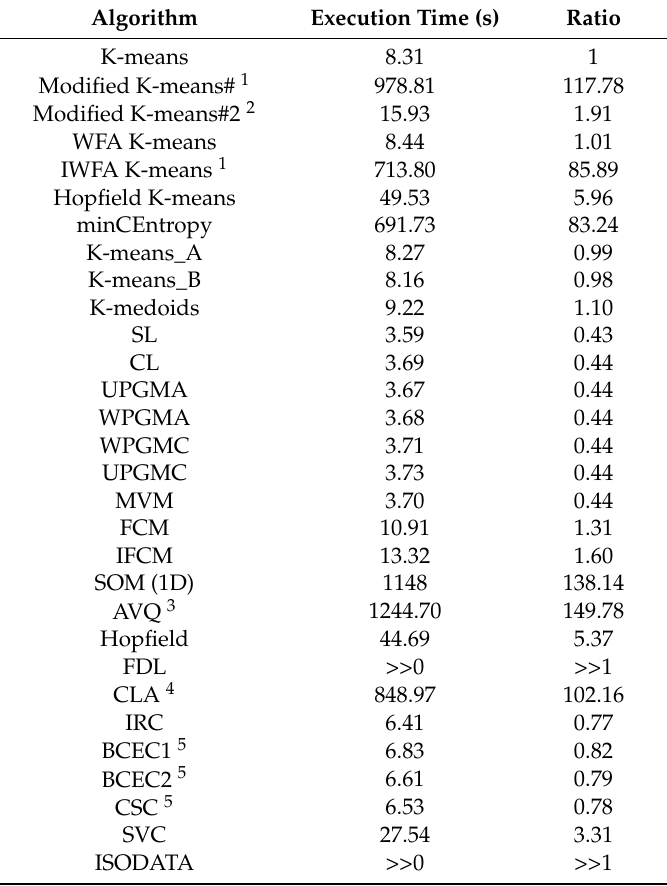
Table 9. Required execution time per algorithm.